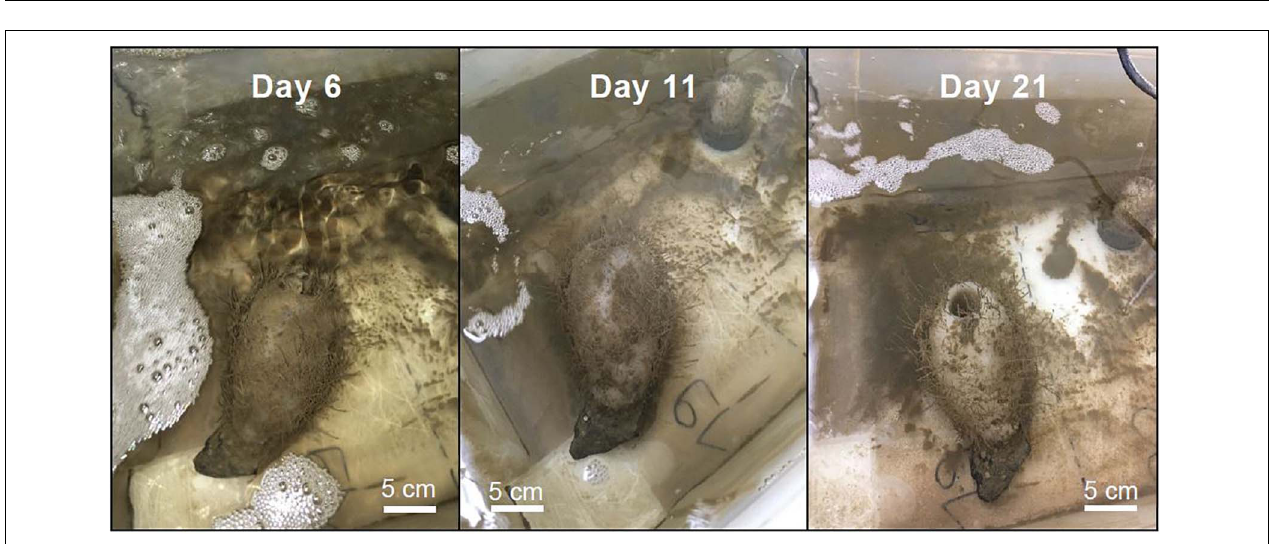
FIGURE 9 | Left: Vazella pourtalesii in top view with flocculated matter (black arrows) accumulated in the tank after initial removal of settled sediment particles Right: V. pourtalesii in experimental tank with accumulated sediment particles on the tank bottom after 12 h of exposure.